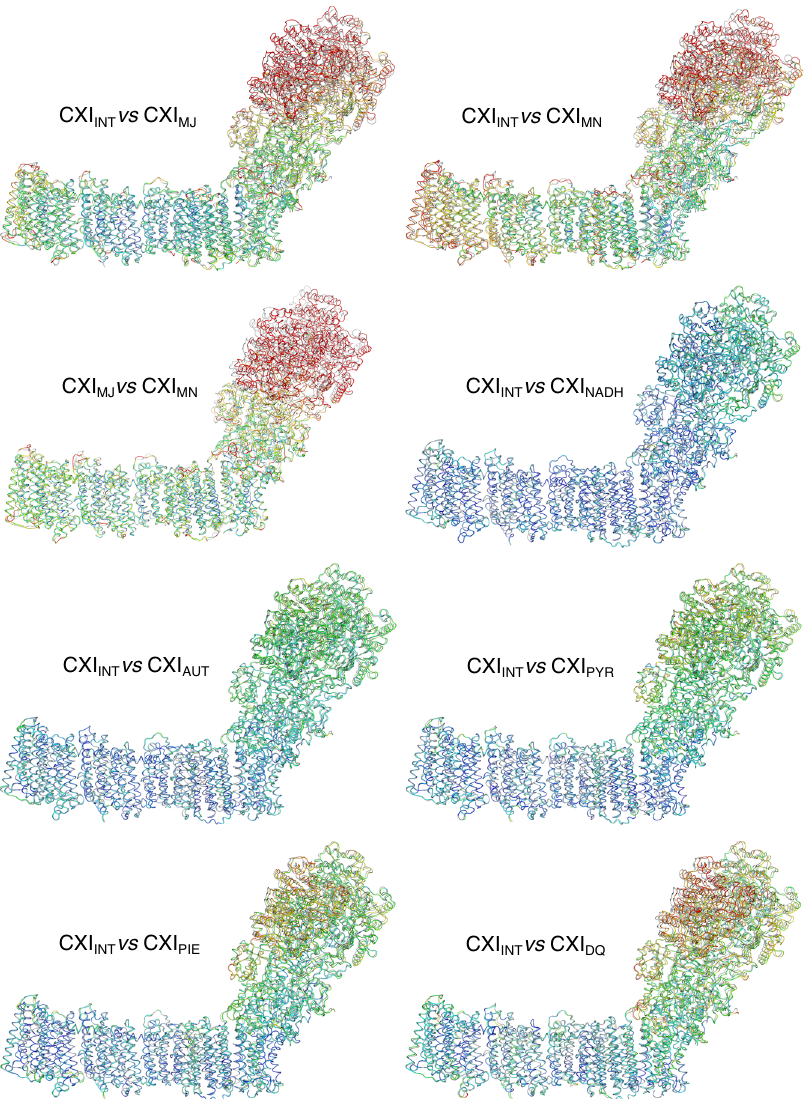
Fig. 3 Different conformations of complex I. Models were aligned by C α atoms of the membrane domain and coloured by C α RMSD. Structure of native CXI INT state is in grey. RMSD values range from 0 Å (blue) to 3 Å (red) or higher. Cryo-EM structures show signi fi cant PA rotation. Among the crystal structures, the DQ-bound structure (bottom right) shows the most signi fi cant conformational